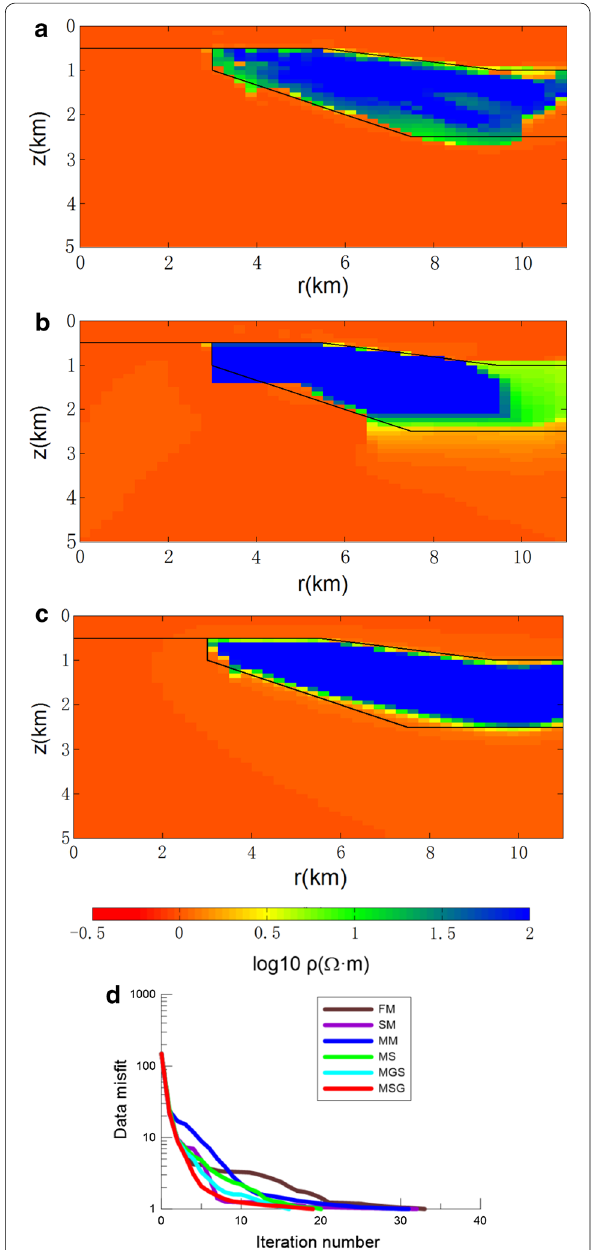
Fig. 11 Synthetic inversion results for the 2D resistive model (Fig. 6a) using different stabilizing functionals with β 2 MSG results, and d convergence of RMS data misfit. Color scale is the